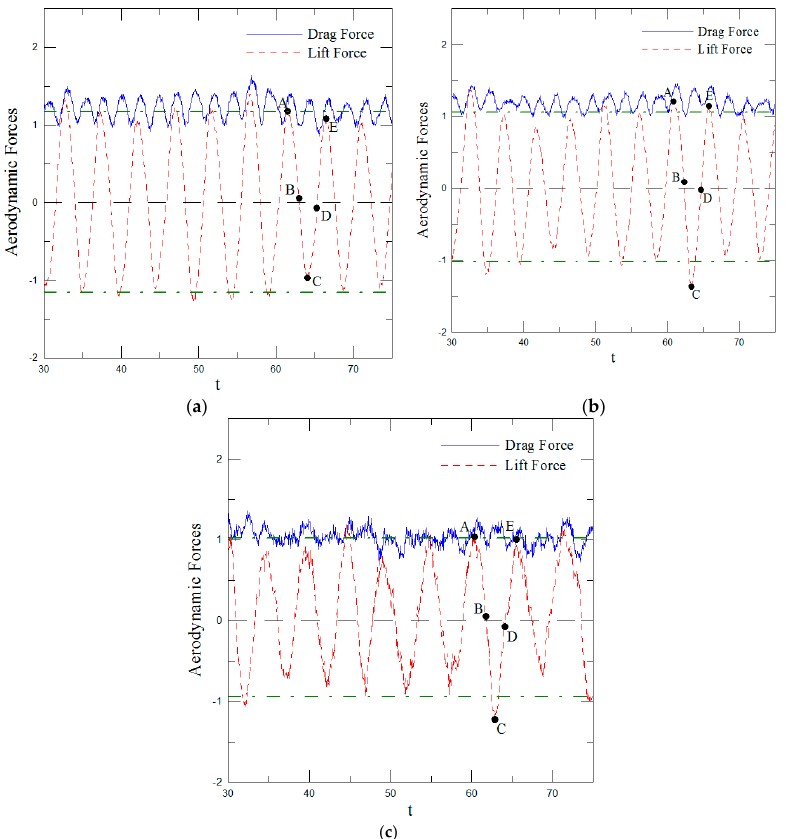
Figure 7. Temporal history for drag and lift coefficients (Re = 1.0 × 10 5 ): ( a ) Smooth; ( b ) ε = 0.10%; ( c ) ε = 0.45%.